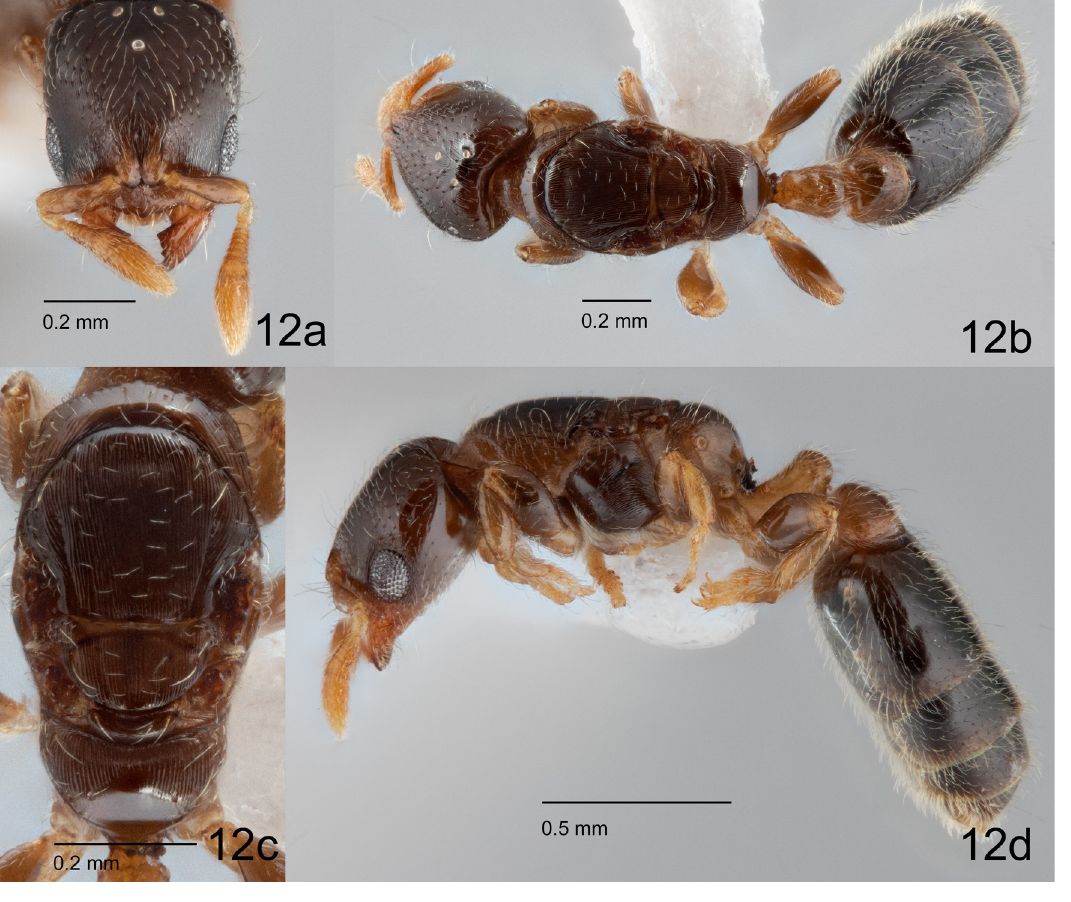
Fig. 12. Rhopalomastix parva Wang & Jaitrong sp. nov., paratype, queen (ZRC_ENT00013948). a . Head in full-face view. b . Body in dorsal view. c . Close-up of mesosoma in dorsal view. d . Body in lateral